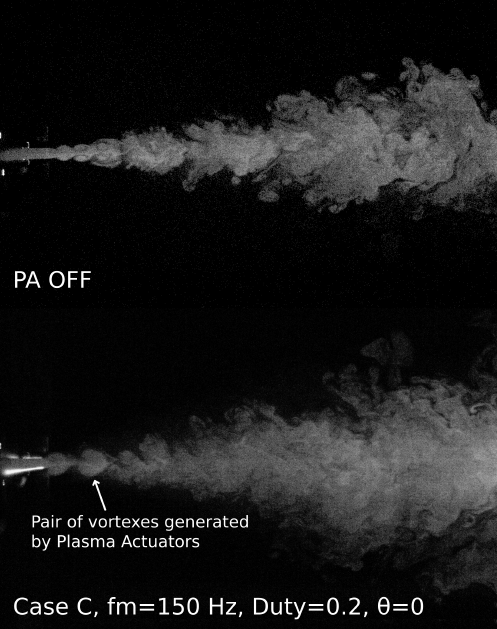
Figure 10. Images of flow visualized by PIV laser sheet and high-speed camera (Side